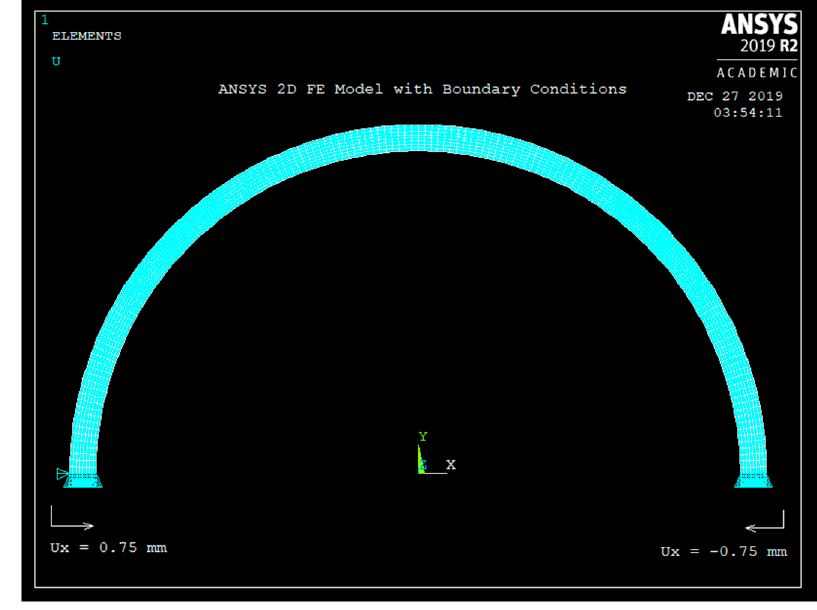
Figure 6. ANSYS Finite Element (FE) Model.